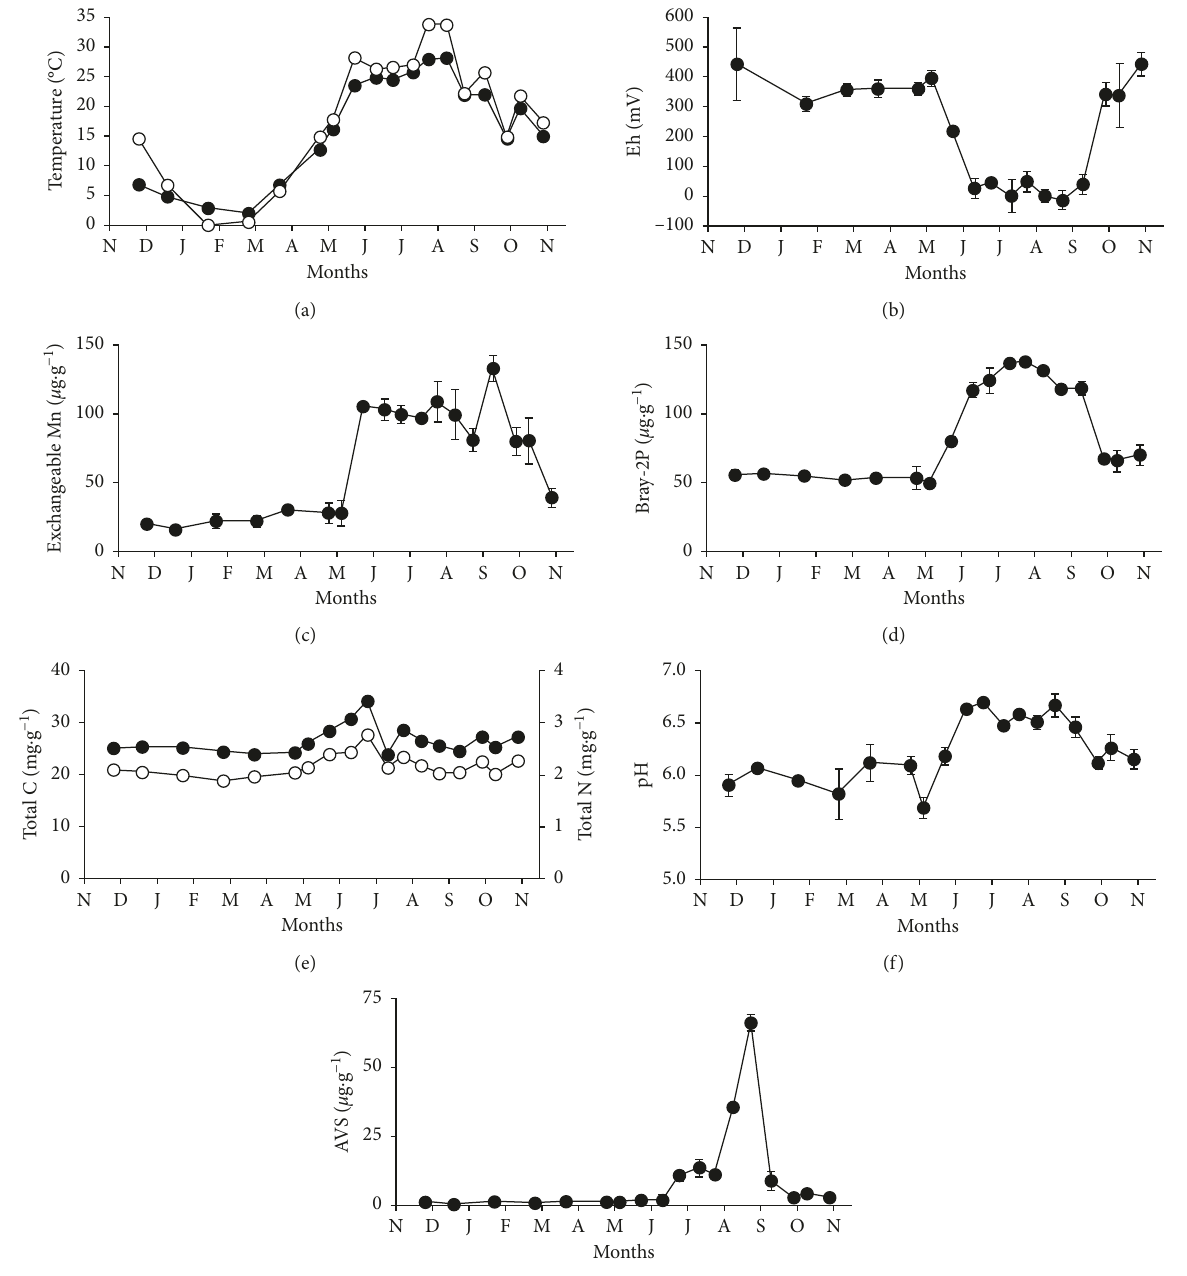
Figure 1: Annual variations in soil physicochemical properties in a paddy field. (a) Air and soil temperatures. Filled circle, soil temperature; open circle, air temperature; (b) soil Eh; (c) exchangeable Mn; (d) Bray-2P; (e) total C and N. Filled circle, total C; open circle, total N; (f) soil pH; (g) acid-volatile sulfide. Data points represent means, and the error bars represent standard